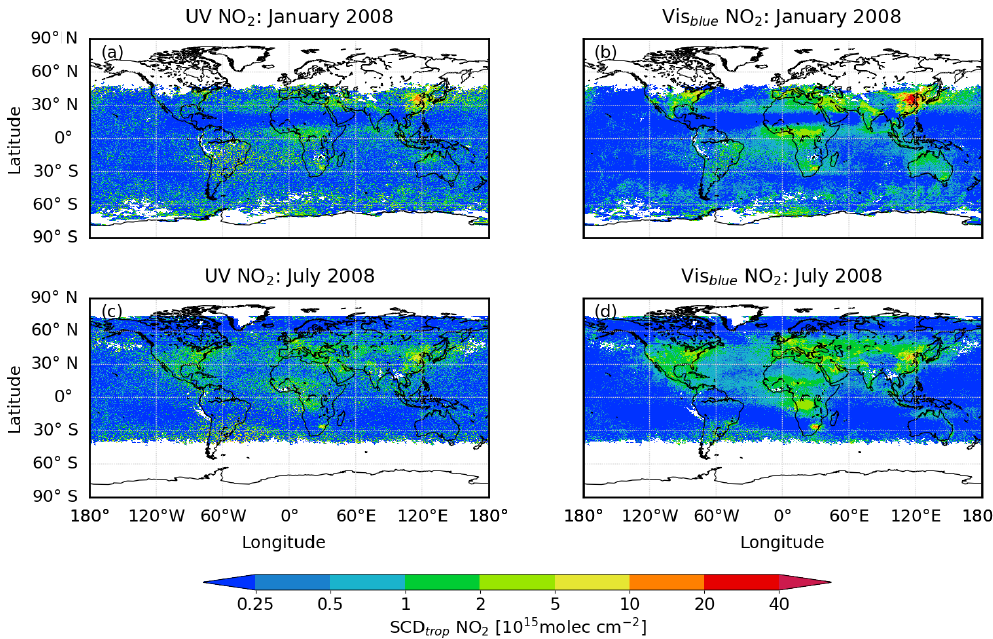
Figure 7. Monthly mean tropospheric NO 2 SCDs for (a, b) January and (c, d) July 2008. (a, c) UV spectral range and (b, d) blue spectral